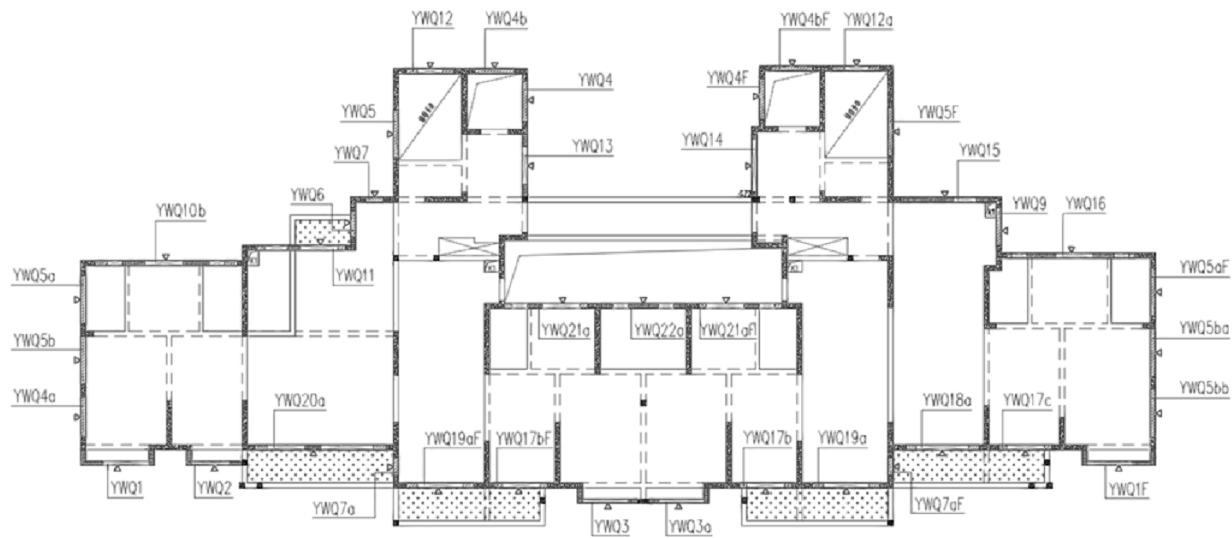
Figure 5. Plan of vertical prefabricated components of buildings #6 and #7.